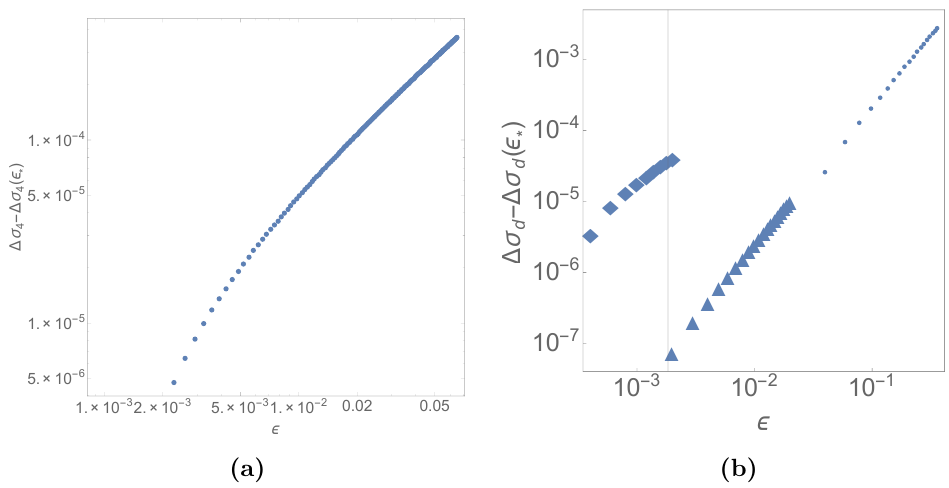
Figure 8. Above we show in a log-log plot the error in extracting (cid:1) (cid:27) d as a function of the cuto(cid:11), (cid:15) . In (a), we do this for d=3 for (cid:22) = 3 and R = R + . In (b), we do this for R=R + = 3 in d = 4 ( (cid:7) ), d = 5 ( N ), and d = 6 ( (cid:15) ). In all cases, we see a power-law